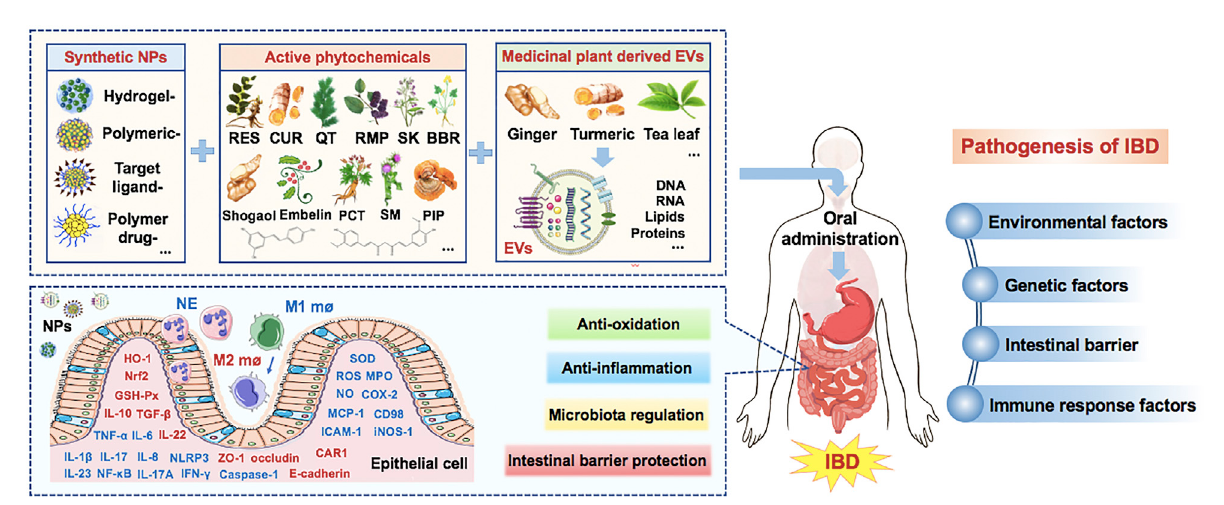
FIGURE 1 Medicinal plant-based drug delivery system for IBD. (Note: Factors in red are upregulated by NPs, while factors in blue are downregulated by NPs. IBD, In fl ammatory bowel disease; EVs, extracellular vesicles; RES, resveratrol; Cur, curcumin; QT, quercetin; RMP, ramulus mori polysaccharide; SK, shikonin; BBR, berberine; ROS, reactive oxygen species; NPs, nanoparticles; CAR1, carbonic anhydrase 1; MPO, myeloperoxidase; PCT, piceatannol; SM, silymarin; Se, selenium; SOD, superoxide dismutase; MCP-1, monocyte Chemoattractant Protein 1; ICAM-1, intercellular cell adhesion molecule-1; HO-1, heme oxygenase; Nrf2, Nuclear factor erythroid 2-related factor